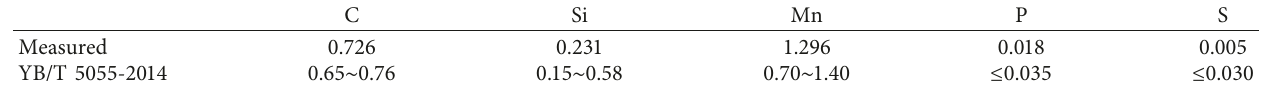
Table 1: Chemical composition of U71Mn rail steel (wt. %).